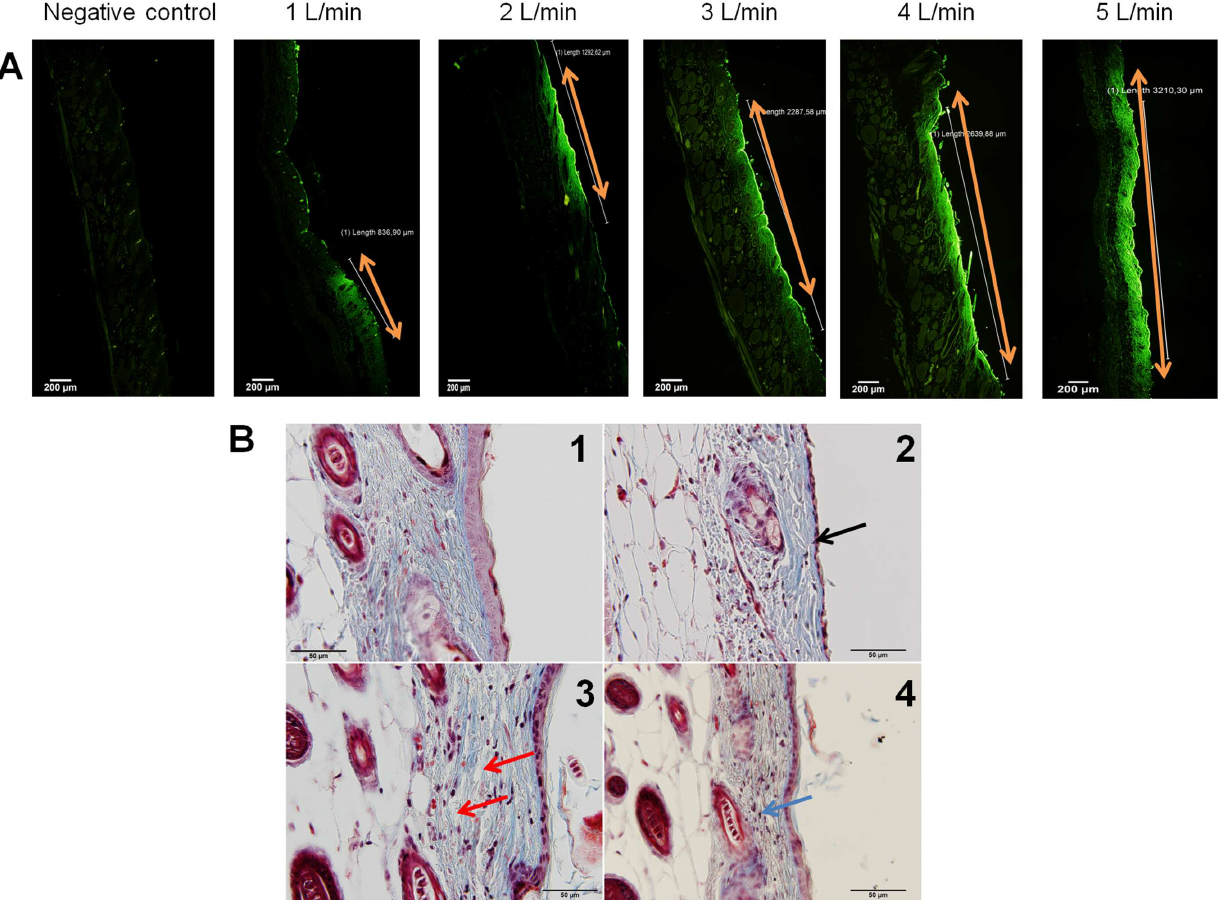
Fig 4. Histological evaluation of skin damage. Skin treated under different plasma flow rates (from 1 to 5 L/min) was excisedand 5 μ m thick sections were cut and stainedwith haematoxylin and eosin or Masson’strichrome. Skin sections were observedunder BX-51 microscope (Olympus) and histologically evaluated.A) The skin exposedto FITC, visualized under RGB conditions. Skin sections were stained with hematoxylinand eosin. Orange arrow marks the central fluorescent area, where the skin samples were further histologically evaluated. Scale bar : 200 μ m. B) Histological evaluationof damagedskin, performed under visiblelight. Skin sectionswere stainedwith Masson’s trichrome. 1) Control un-treatedskin. 2) The black arrow points to reducedcell layers of epidermis (single layer of epidermal cells visibleunder flow rate of 5 L/min).3) Red arrow presents the oedemaand destructed structure of collagenfibers (obtained under flow rate of 4 L/min). 4) Blue arrow presents the immune cell infiltration(obtainedunder flow rate of 3 L/min). Scale bar : 50 μ m.